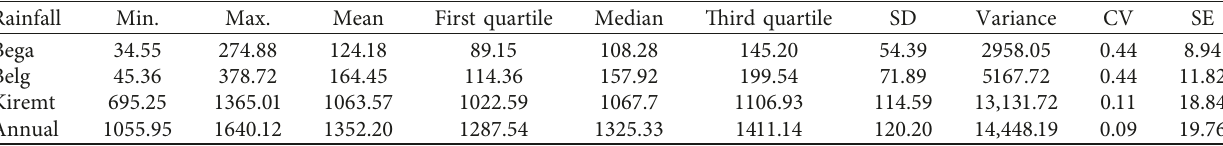
Table 3: Descriptive statistics of the seasonal and annual rainfall in the LTB.